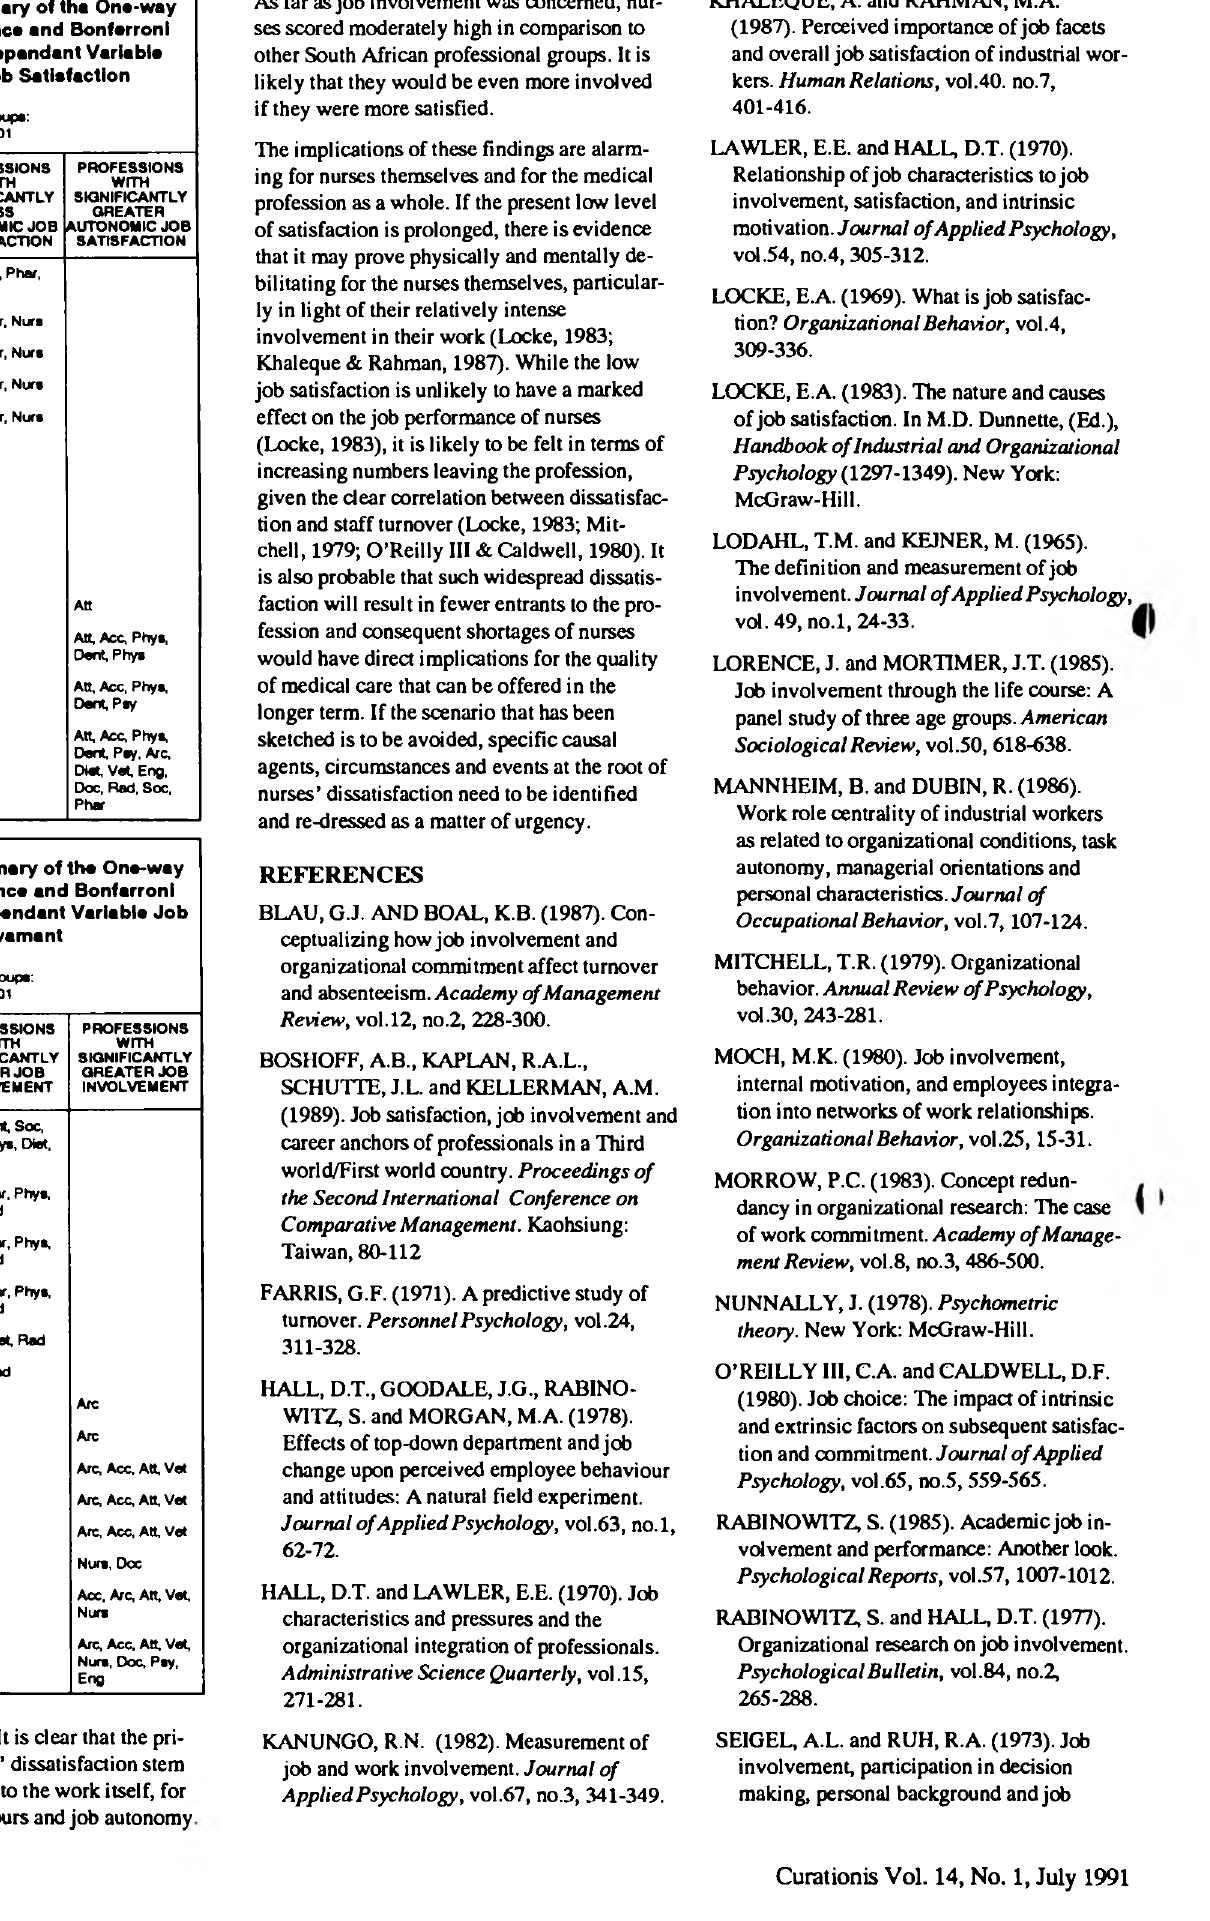
TABLE VII. Summary of tha Ona-way Analysis of Variance and Bonfarronl rang»* tast for Dapandant Variabla Autonomic Job Satisfaction Over ail difference among groups: F (13;1770) - 14,06, P< ,0001 PROFE­ MEAN PROFESSIONS SSION WITH SIGNIFICANTLY